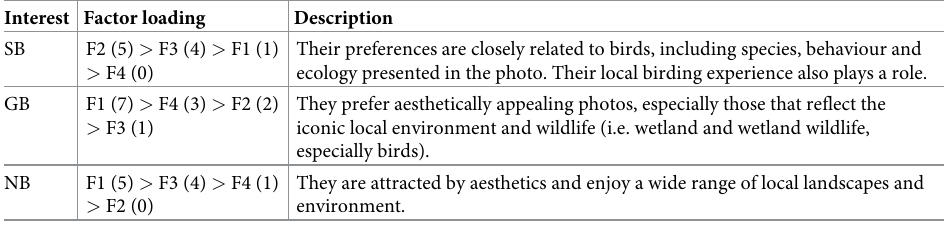
Table 7. The characteristics/preferences of SB, GB and